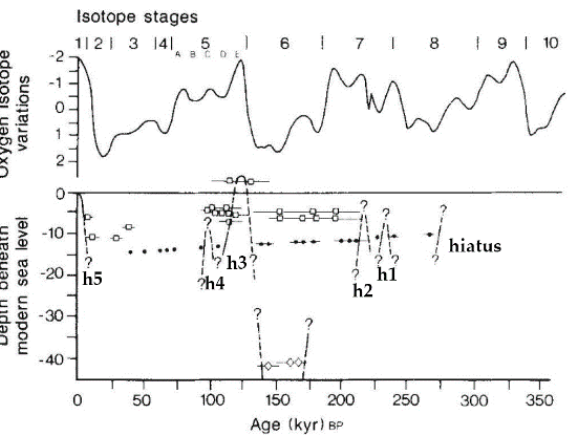
Figure A2. GIA for Caribbean Islands and Florida (redrawn from [39]).